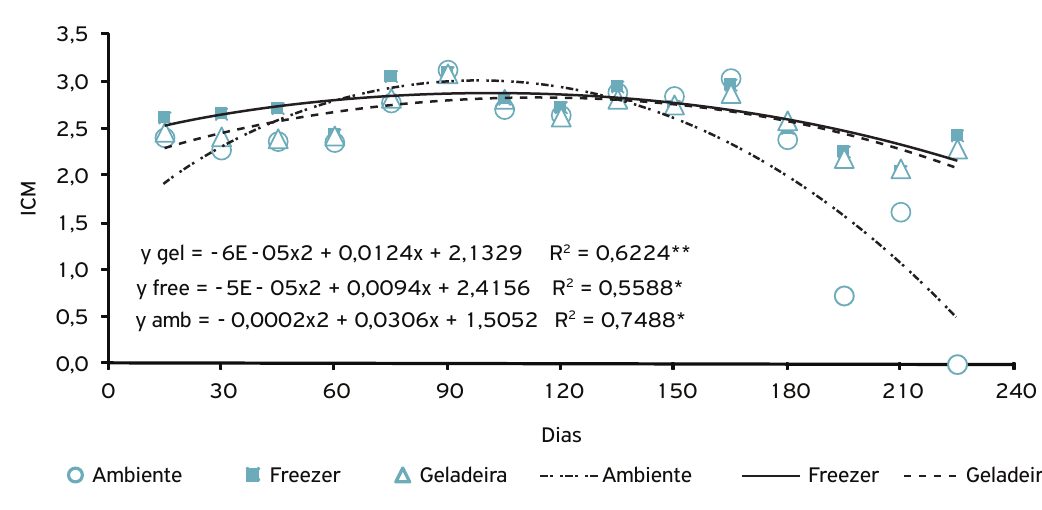
Figura 2. Crescimento micelial de C. cladosporioides imobilizado em alginato de sódio e armazenado em diferentes temperaturas.